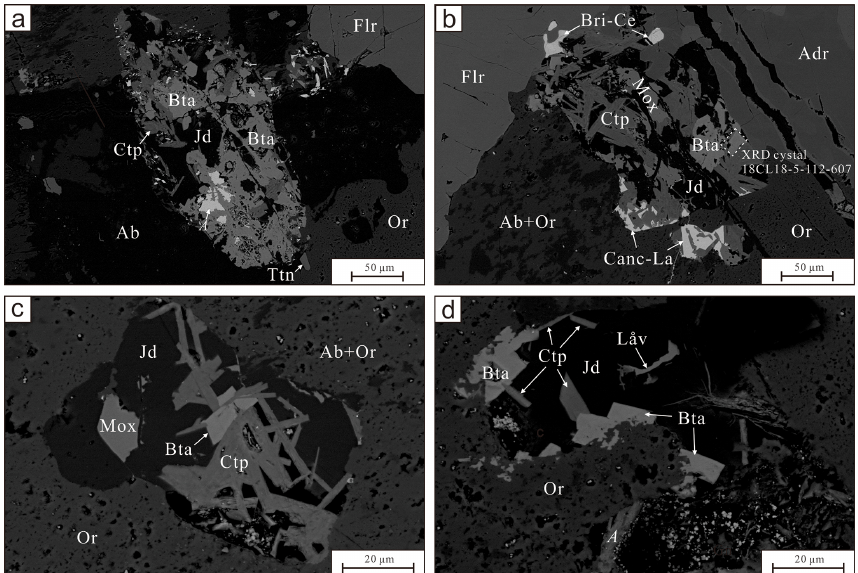
Figure 2. Back scatter electron image of the occurrence and mineral association of bobtraillite. Bta: bobtraillite, Jd: jadeite, Ab: albite, Or: orthoclase, Fl: fluorite, Adr: andradite, Ttn: titanite, Ctp: catapleiite, Mox: moxuanxueite, Låv: låvenite, Bri-Ce: britholite-(Ce), and Canc-La: calcioancylite-(La). Mineral symbols are quoted from Warr